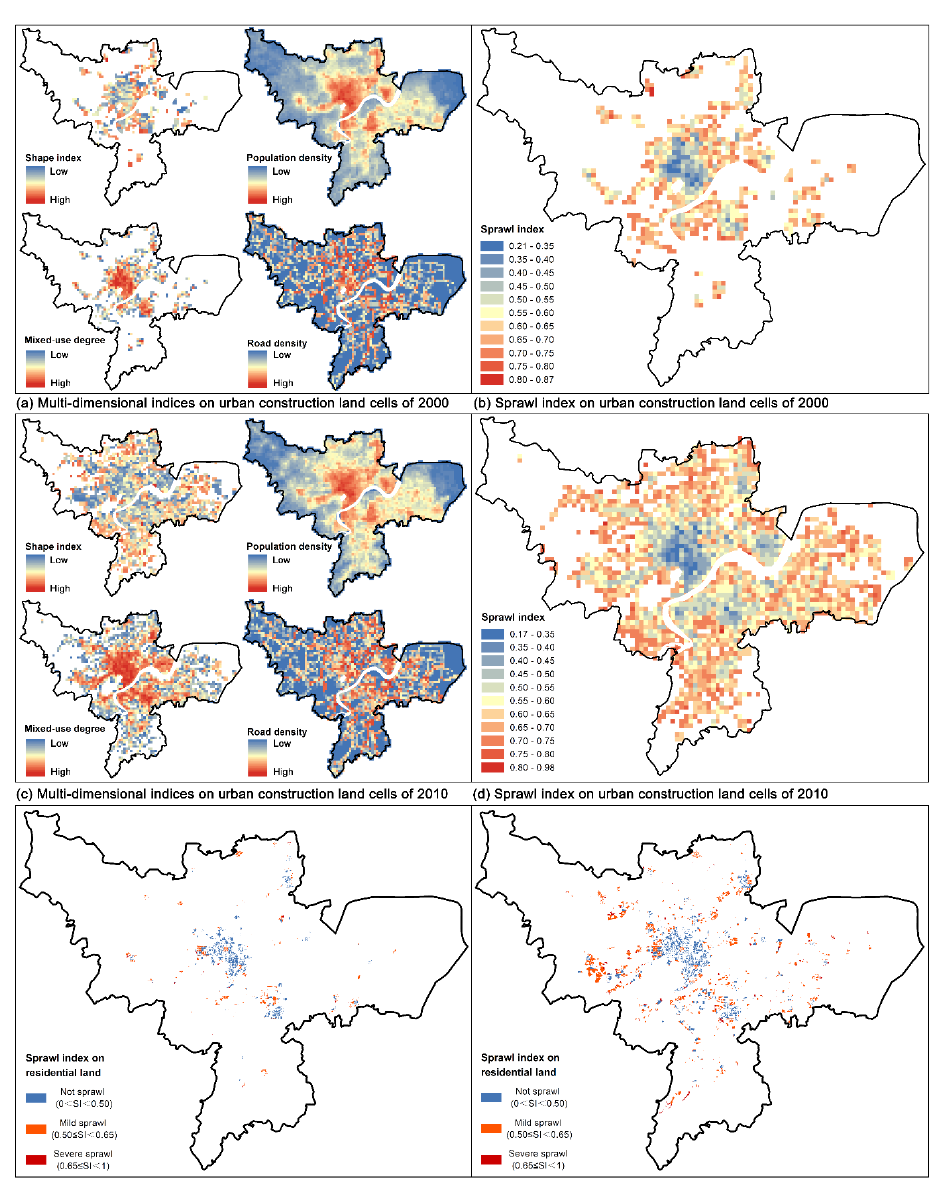
Figure 4. The layout of multi-dimensional measuring indices and sprawl index on 1 km × 1 km cells: ( a ) Multi-dimensional indices on urban construction land cells of 2000; ( b ) Sprawl index on urban construction land cells of 2000; ( c ) Multi-dimensional indices on urban construction land cells of 2010; ( d ) Sprawl index on urban construction land cells of 2010; ( e ) Sprawl index on residential land cells of 2000; ( f ) Sprawl index on residential land cells of 2010. For the terms of each dimension, as shown in Figure 4a,c, the variation of shape index, population density, mixed-use degree, and road density corroborated an aggravating sprawling tendency in the city. For example, the average population density of cells within the urban core increased from 23,768 persons per km 2 to 30,405 persons per km 2 ,